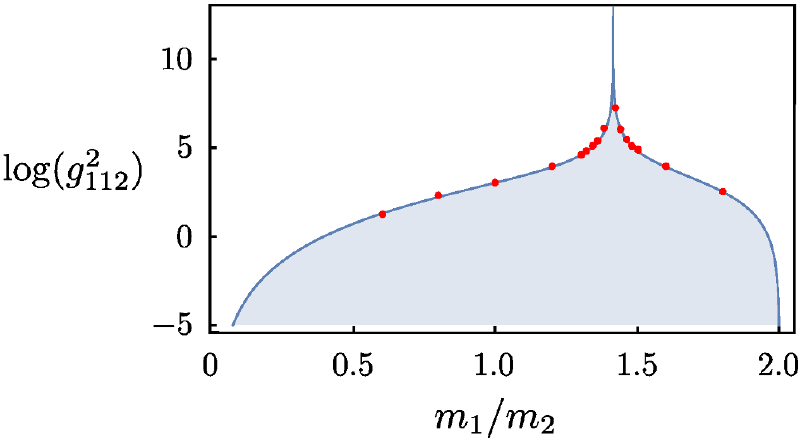
Figure 7 . The double extrapolation to in(cid:12)nite N and to the (cid:13)at-space limit results in the plotted points, each one corresponding to a di(cid:11)erent ratio (cid:1) 2 = (cid:1) 1 ’ m 2 =m 1 . The blue curve is the exact result of the S-matrix bootstrap obtained in our companion paper